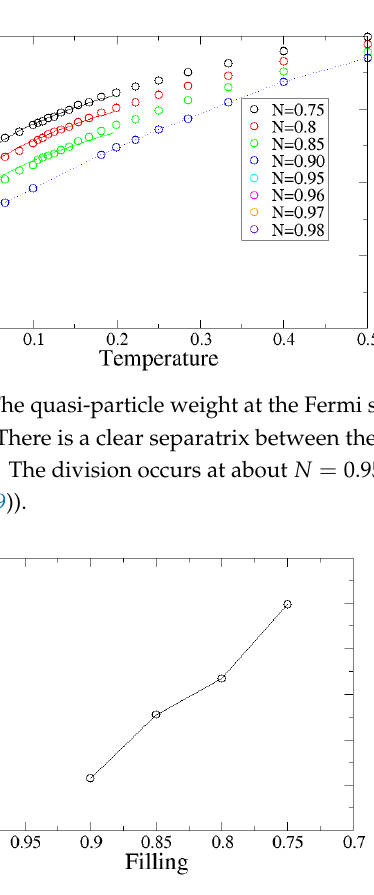
Figure 4. The crossover temperature, T X , as a function of filling. The crossover temperature decreases as the filling increases, pointing to the presence of a critical